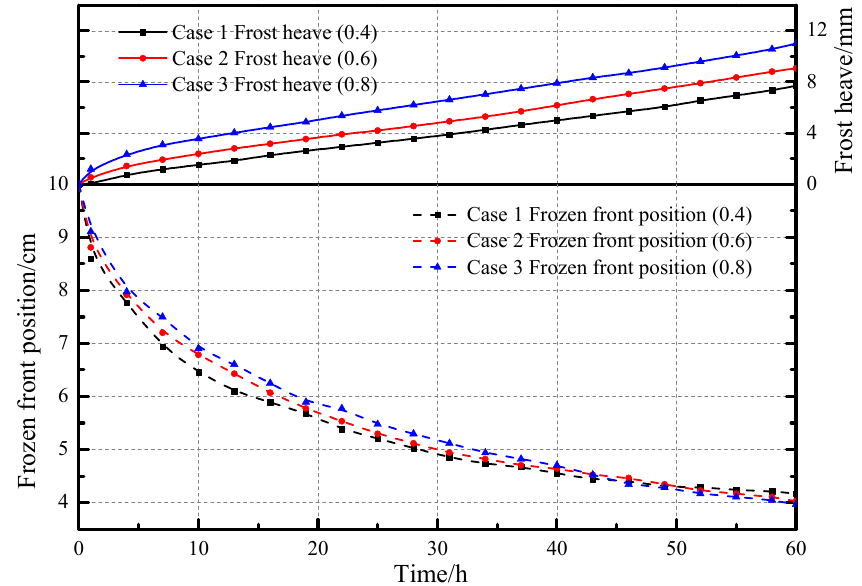
Figure 8. Freezing process curves of cases 1, 2, and 3.